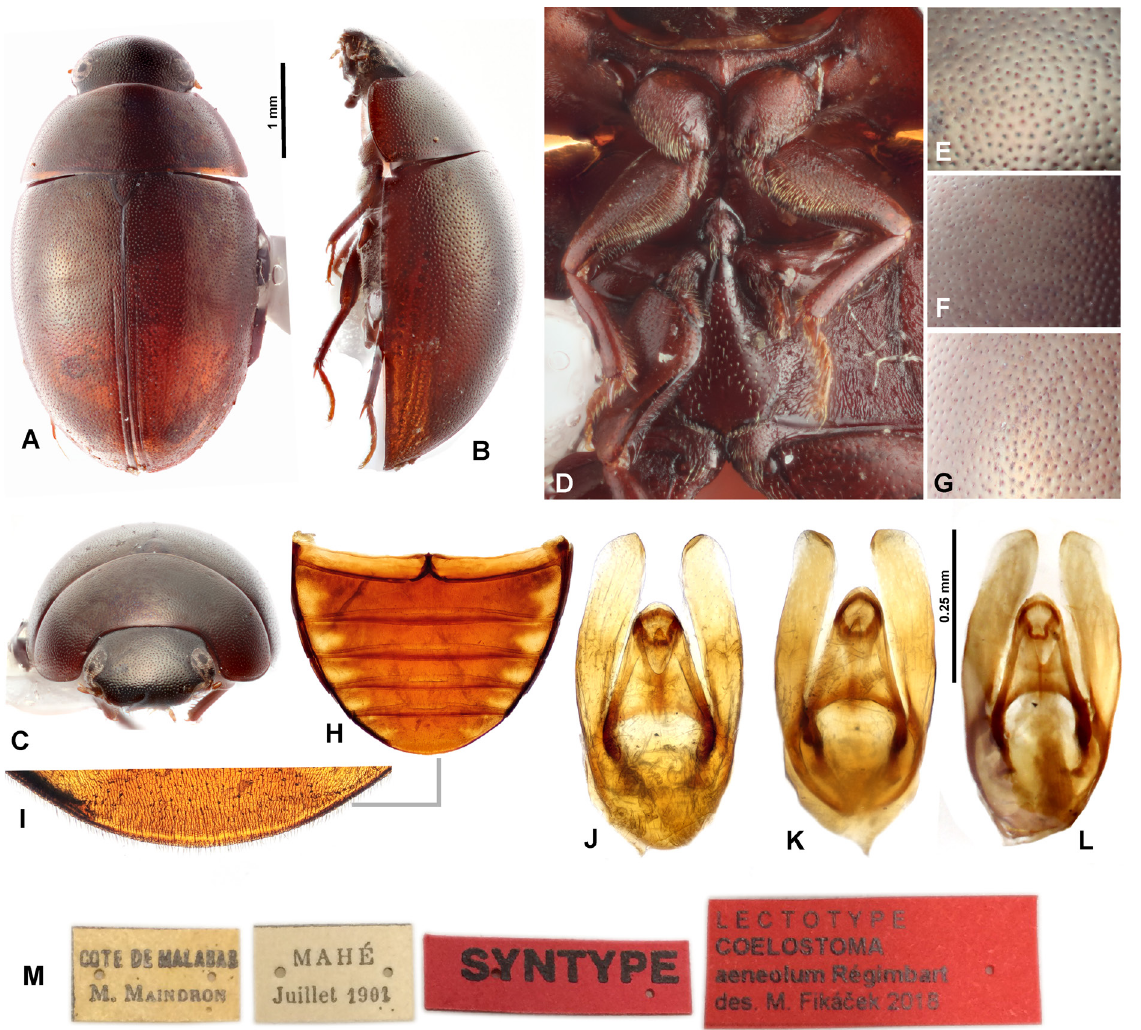
Fig. 3. Coelostoma (s. str.) aeneolum Régimbart, 1903, lectotype. A . Dorsal habitus. B . Lateral